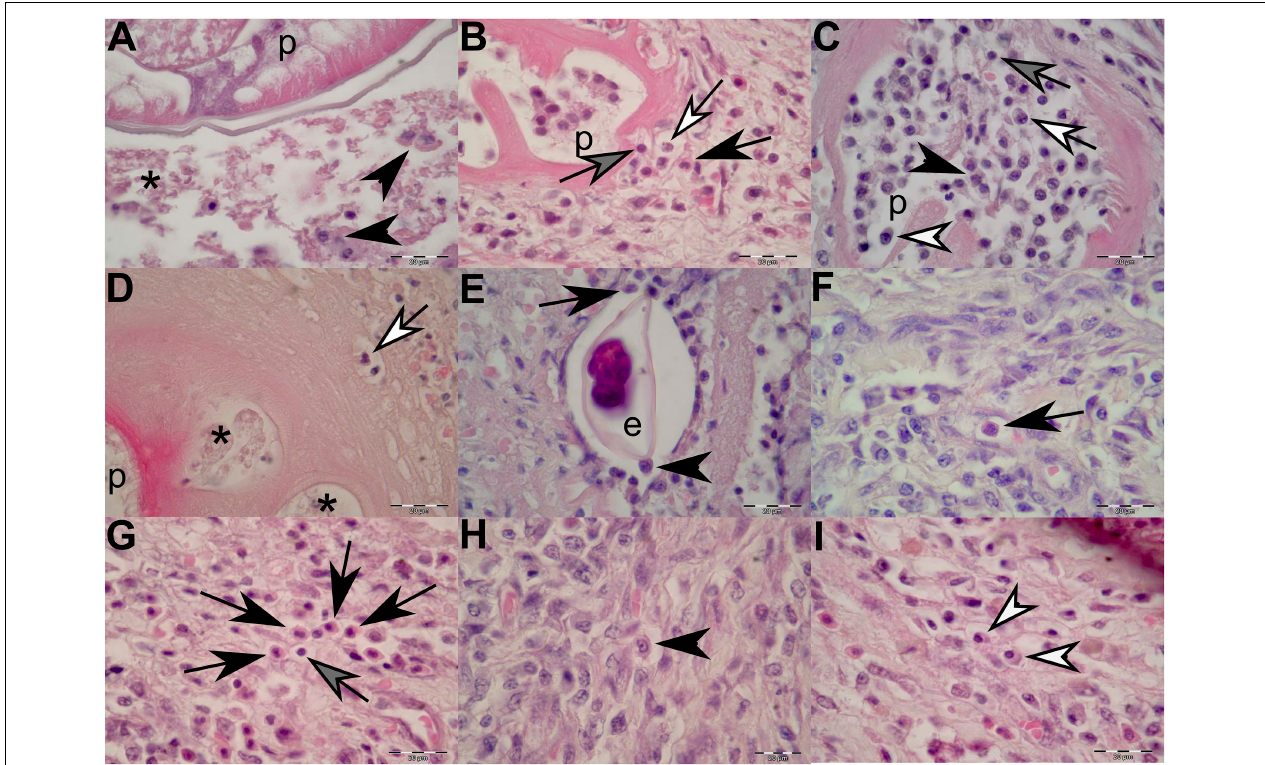
FIGURE 5 | Histopathological findings of gastric lesions in California sea lions ( Zalophus californianus ) necropsied at the Marine Mammal Care Center in San Pedro, California, United States (spring and summer 2017 and 2018), affected by parasites of Anisakidae family. (A) Interface of the parasite and necrotic tissue composed of cellular debris and macrophages. (B) Lymphocytes, neutrophils, and eosinophils among connective-tissue fibers in close contact with the anisakid. (C) Anisakid pseudocoelom infiltrated by lymphocytes, neutrophils, eosinophils, and plasma cells. (D) Hyaline-like substance enveloping an anisakid, showing vacuolations filled with necrotic debris and neutrophils in early infection stage. (E) Anisakid egg enveloped by a simple squamous epithelium in the tunica submucosa and in close contact with macrophages and eosinophils. (F) A solitary eosinophil and a cluster of eosinophils (G) in the tunica submucosa. (H) A solitary macrophage with visible pseudopodia in the tunica submucosa. (I) Two plasma cell present in the tunica submucosa. p, parasite; *, necrosis; black arrowheads, macrophages; black arrows, eosinophils; gray arrows, lymphocytes; white arrows, neutrophils; white arrowheads, plasma cells. Scale bars: 20 µ m. Staining: H&E.